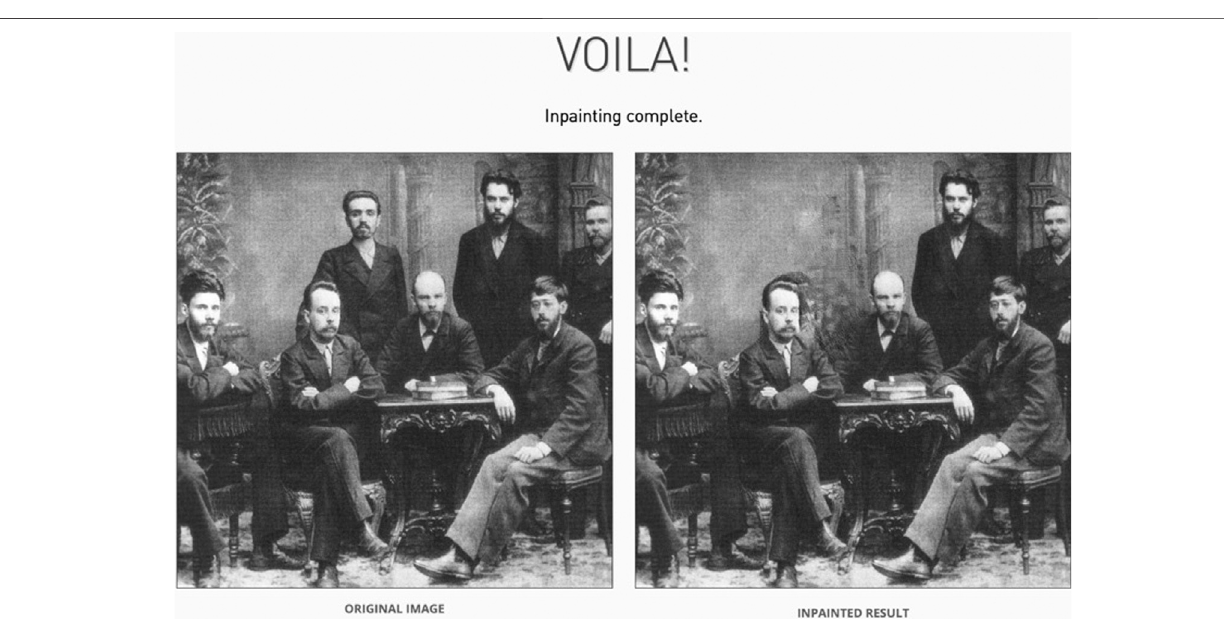
Frontiers in Communication |